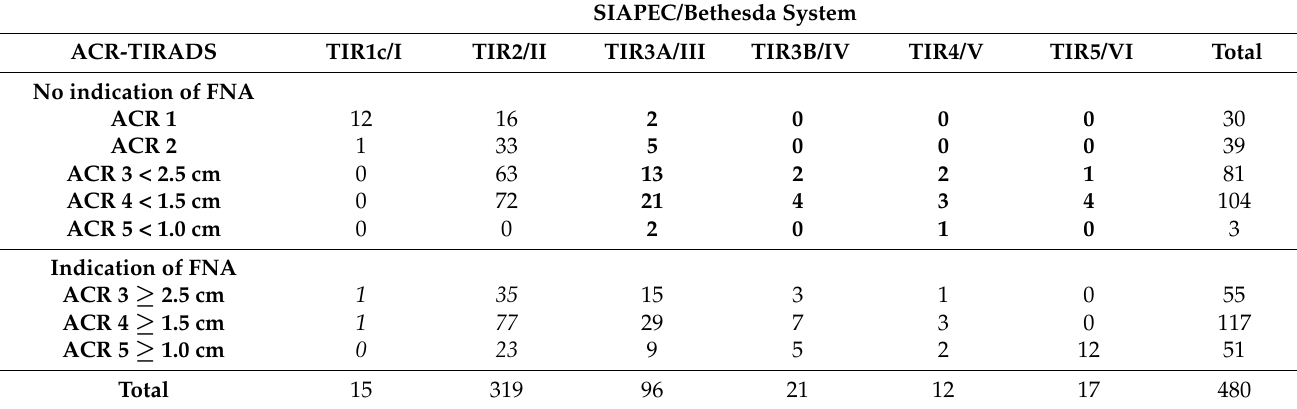
Table 2. ACR-TIRADS vs. SIAPEC/Bethesda system cytological classifications. False negative cases are in bold. False positive cases are in italics.